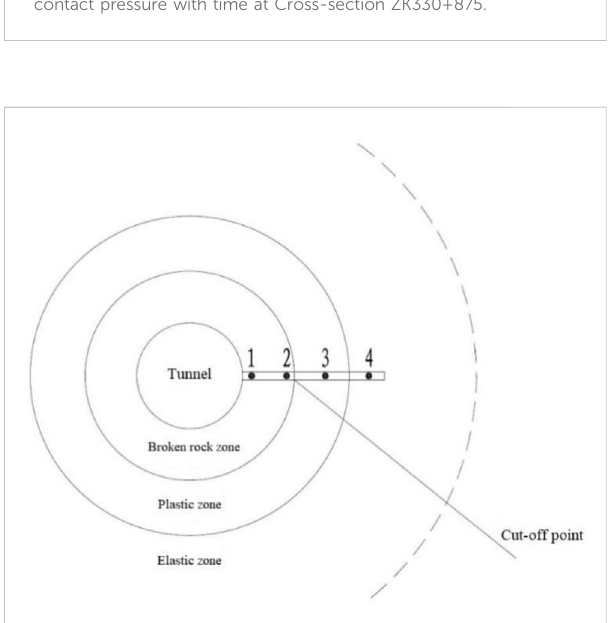
FIGURE 16 The test results of Measuring point 1 at Cross-section ZK331+625 by multipoint displacement meter method.